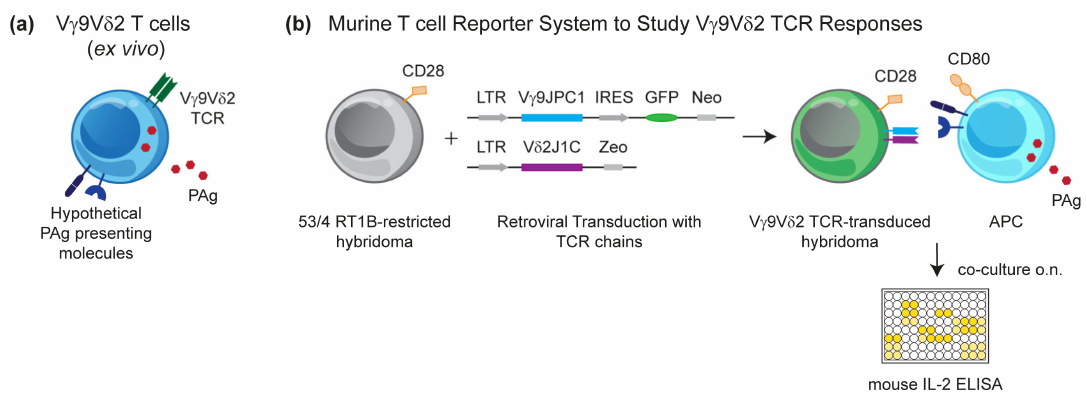
Figure 2. Generation of a murine reporter T cell system. ( a ) Hypothetical phosphoantigen (PAg)-presenting molecules are believed to be expressed ubiquitously and human V γ 9V δ 2 T cells could potentially also present PAg. ( b ) This drawback could be overcome by using murine reporter T cells, which lack an endogenous PAg response. Murine T cell antigen receptors (TCR)-negative 53 / 4 RT1B-restricted hybridoma T cells were transduced with human TRGV9JPC1 (V γ 9JPC1) and TRDV2J1C (V δ 2J δ 1C) constructs encoding V γ 9 and V δ 2 TCR chains, respectively. For co-stimulation, CD28 was overexpressed in hybridoma T cells, and endogenous CD3 enabled TCR complex formation. Thus, generated 53 / 4 V γ 9V δ 2 TCR hybridoma cells could be activated in the presence of PAg when co-cultured with CD80-transduced antigen-presenting cells (APCs) of human origin or other species, provided they are expressing the molecules necessary for PAg presentation. Mouse interleukin (IL)-2 produced by the T cell hybridoma in overnight co-cultures was measured as read-out for reporter T cell